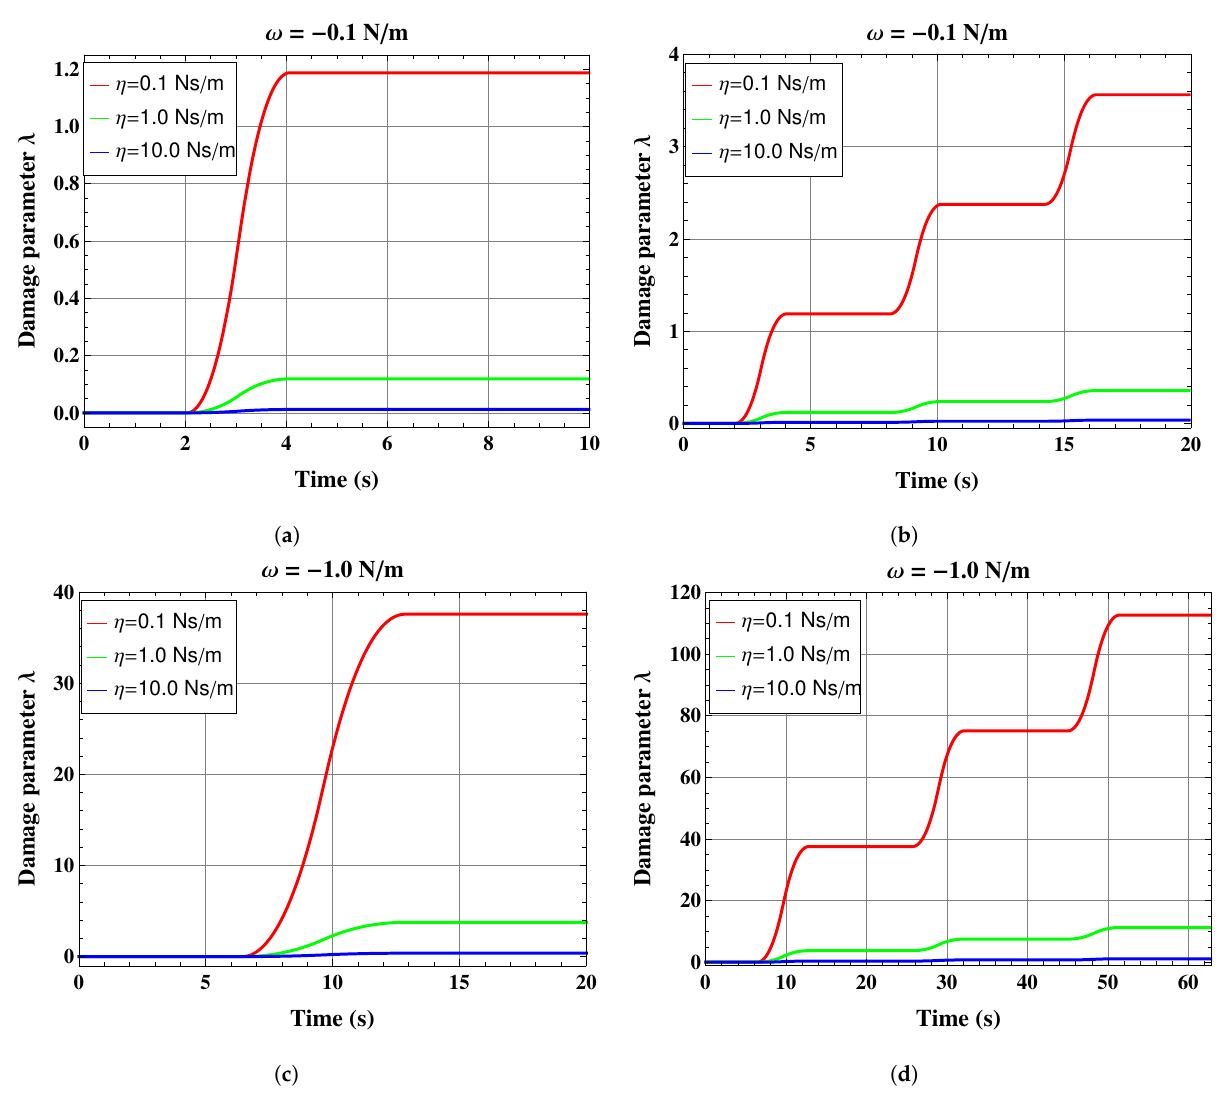
Figure 3. Damage evolution in a single loading–unloading cycle ( a , c ) and in multiple loading– unloading cycles ( b , d ) of the layered composite depicted in Figure 2. The different plots show the effect of varying ω and η in in the damage evolution Equation